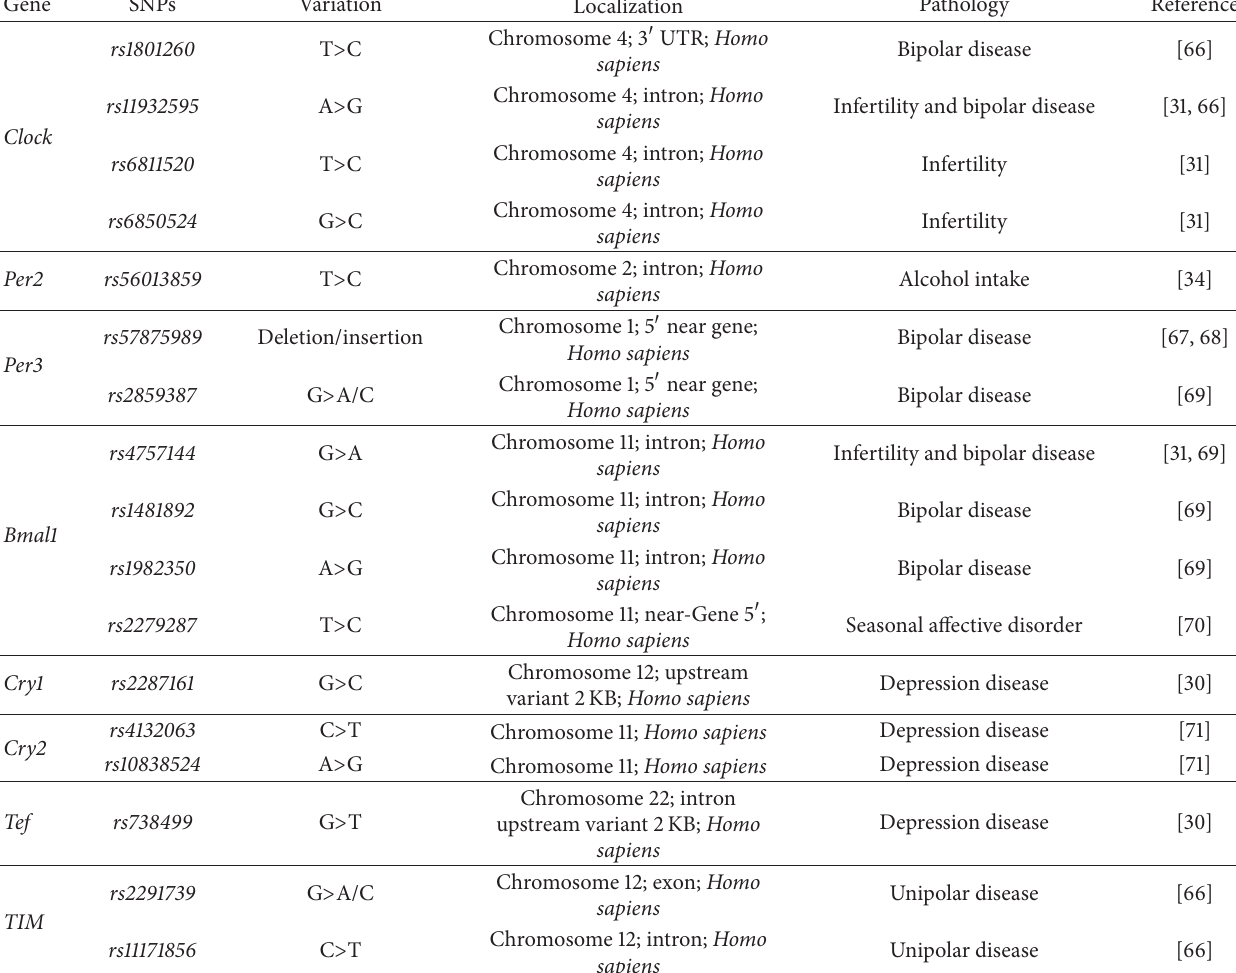
Table 2: Polymorphisms of clock genes associated with infertility and mood